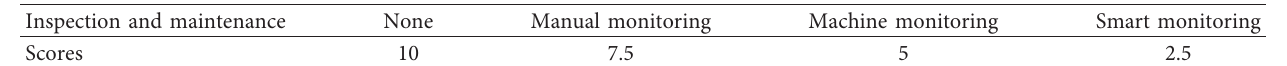
Table 16: The scores of service time.